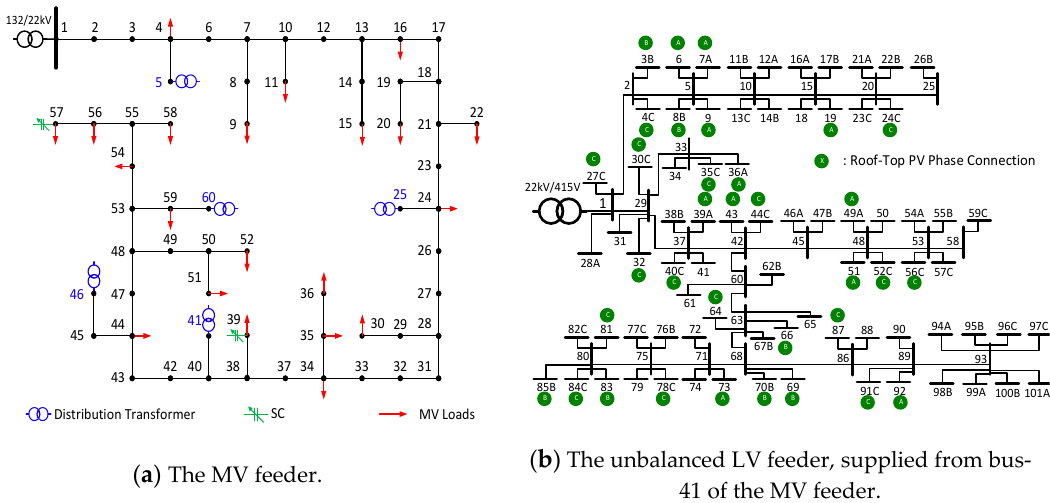
41 of the MV feeder. Figure 11. Considered 565-bus Australian distribution network. Figure 11. Considered 565-bus Australian distribution network. Figure 11. Considered 565-bus Australian distribution network.